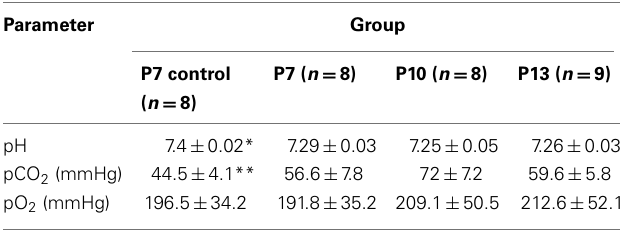
Table 1 |Arterial blood gas parameters for control rats who received 2h of 100% oxygen on P7; rats that received 2h of isoflurane anesthesia on P7 (group P7), both P7 and P10 (group P10), or on P7, P10, and P13 (group